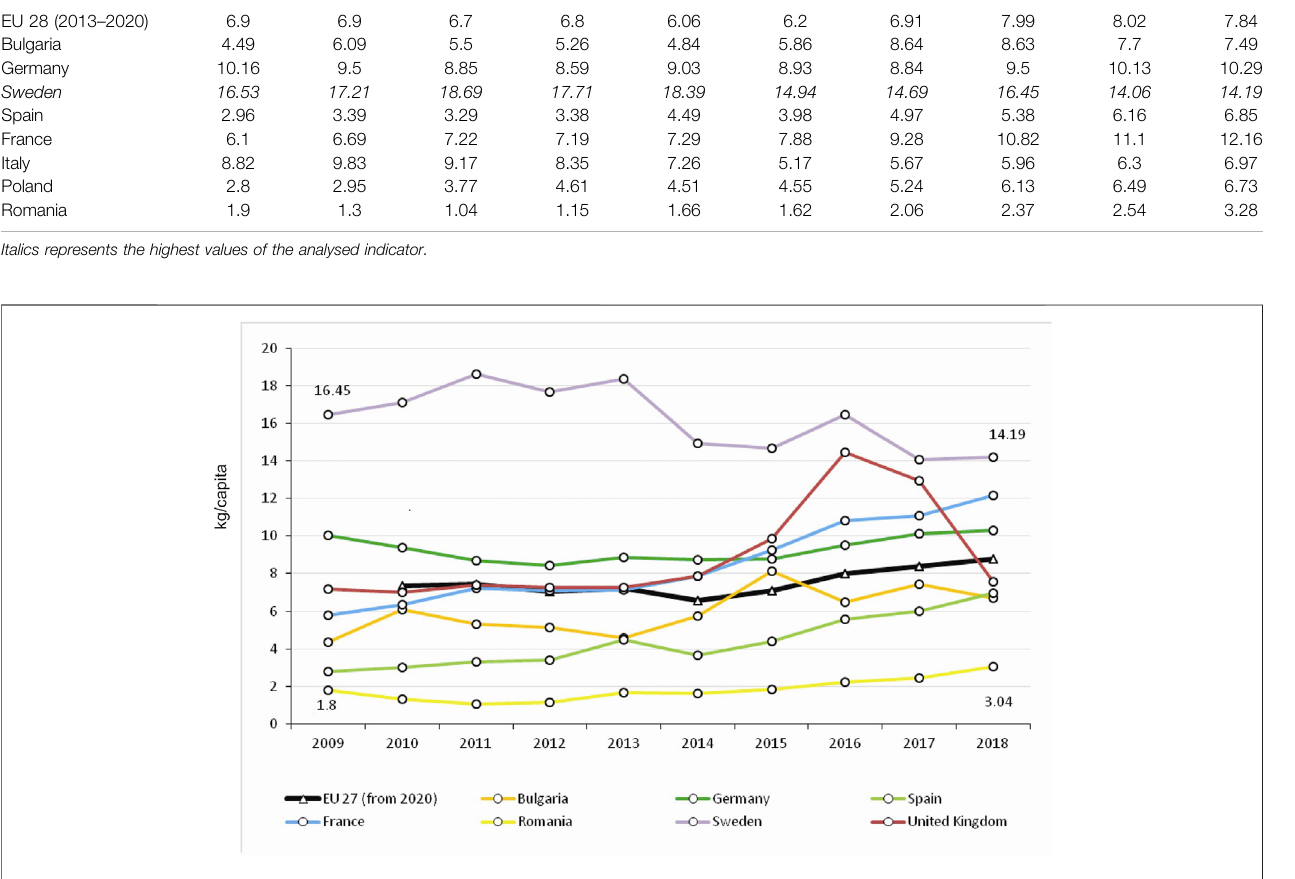
TABLE 1 | Collected e-waste in some EU Countries (kg/inhabit./year)/Source: http://appsso.eurostat.ec.europa.eu/nui/show.do?dataset=env_waselee; Eurostat (2022). Country